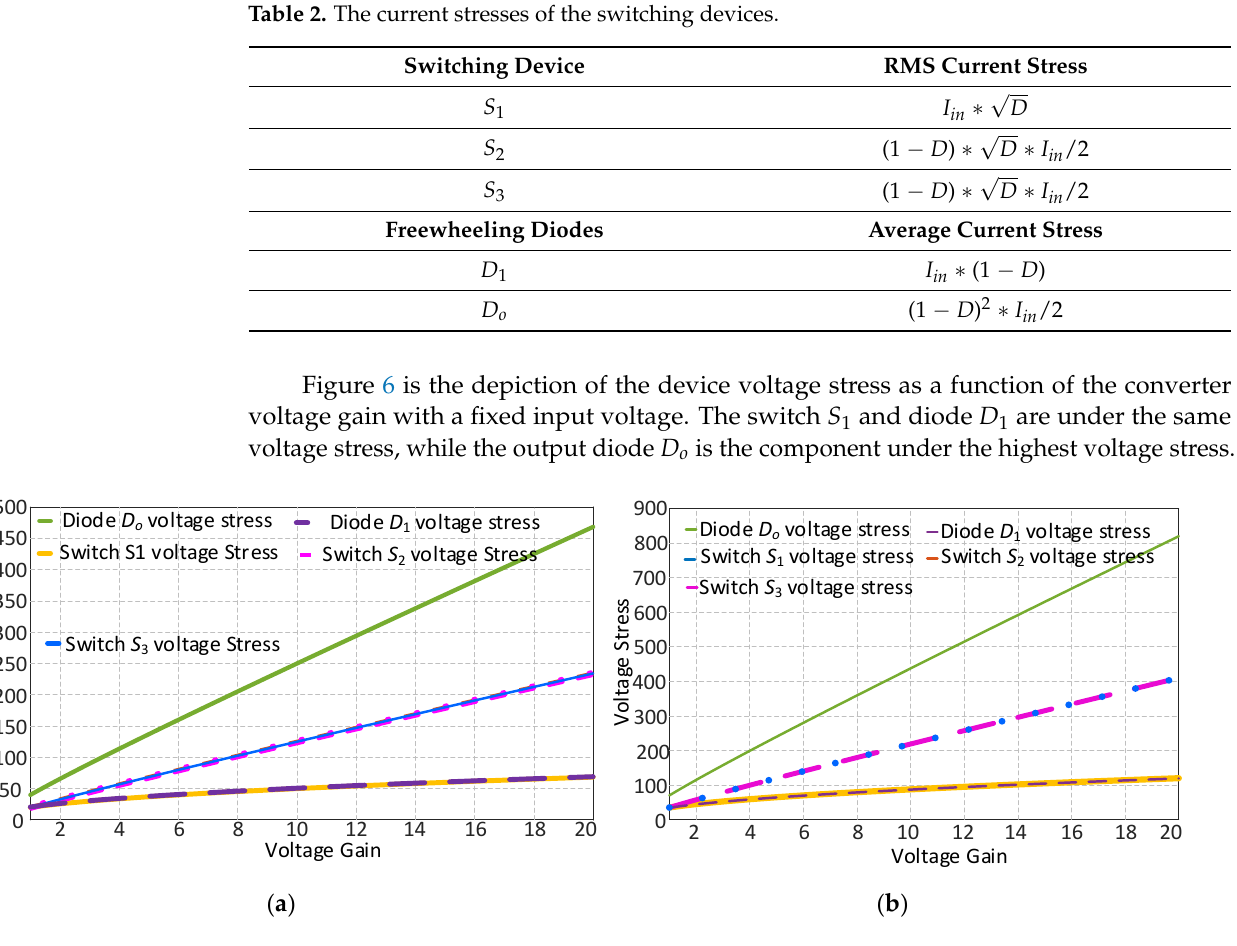
Table 2. The current stresses of the switching devices.